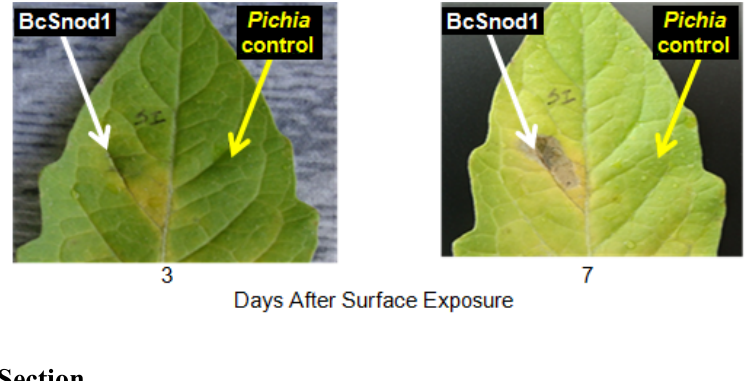
Figure 7. Tomato detached leaf assay of BcSnod1 surface exposure. Seven micrograms of Pichia produced HPLC purified BcSnod1 were pipetted on to the upper surface of a detached tomato leaf. Hypersensitive response started 3 days post infiltration with discoloration observed after day 5. No response was observed at day 3 with minimal discoloration after 10 days for the control